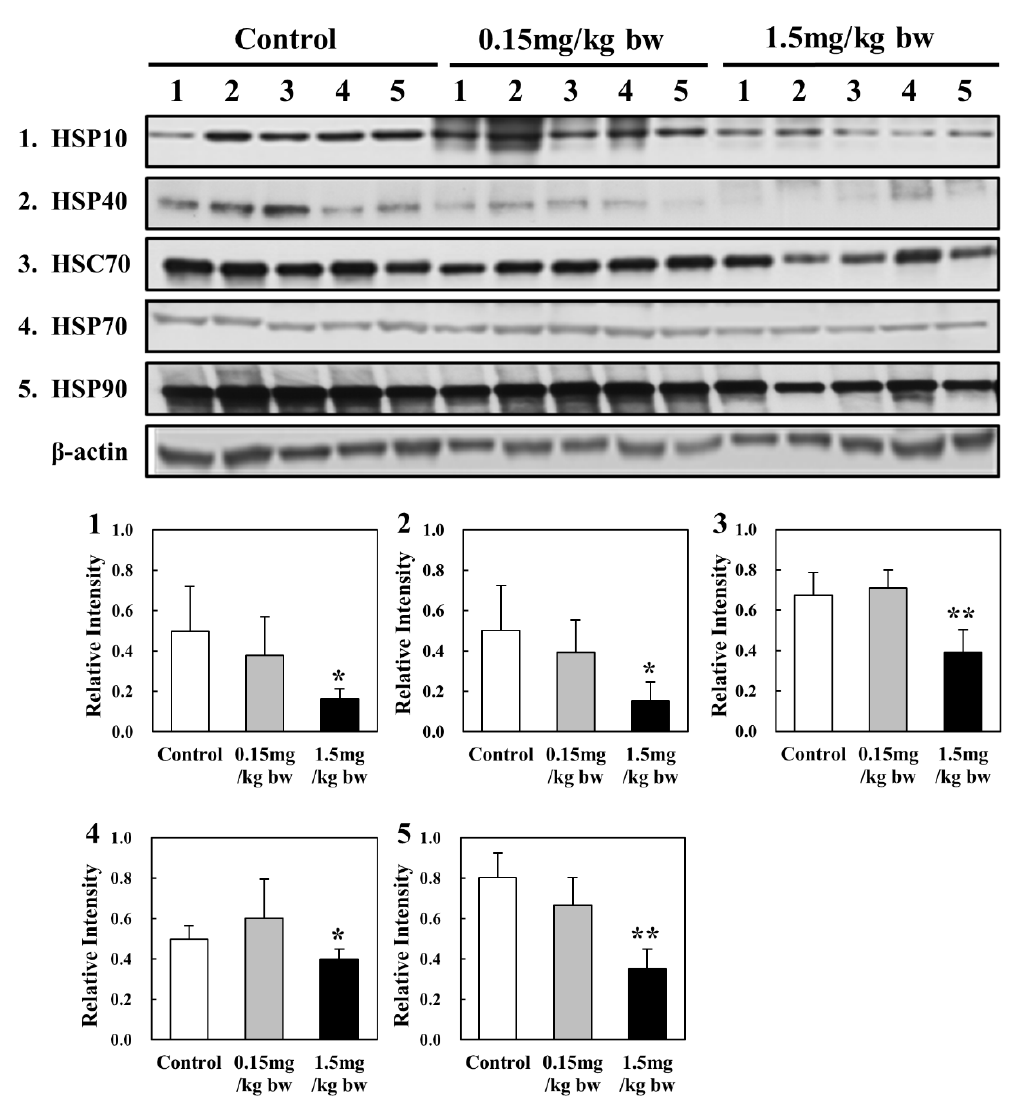
Figure 6. Western blot analysis of HSPs in rat lung tissues: ( 1 ) HSP 10; ( 2 ) HSP 40; ( 3 ) HSC 70; ( 4 ) HSP 70; and ( 5 ) HSP 90. Quantities represented by the gel bands are expressed as intensities relative to β -actin. All relative intensities results are presented as the means ± SD of five experiments; * and ** indicate p -values of 0.05 and 0.01, respectively, compared with the control.